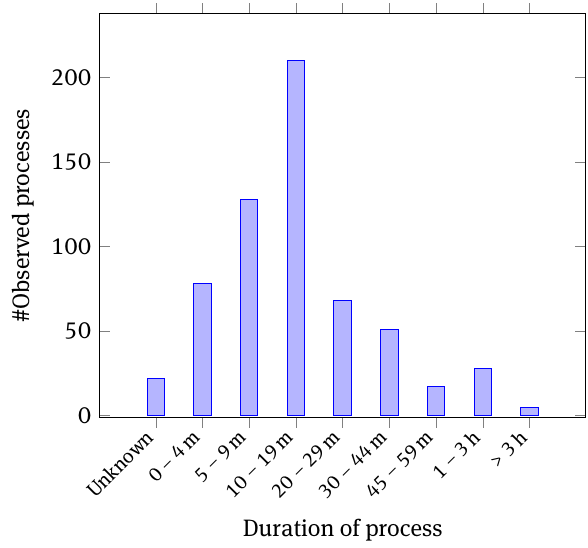
Figure 1: The distribution of the reported processes with respect to their duration. For 22 processes, the duration was not reported, and five processes had a duration exceeding three